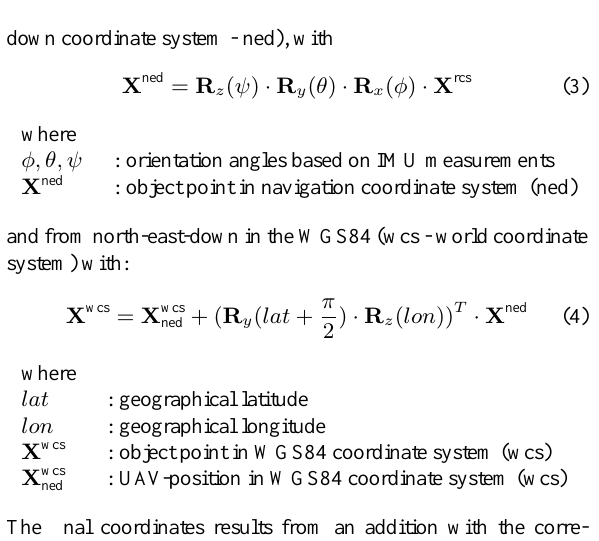
Figure 5: Horizontal profile of pillars from TLS (gray)- and LSRF (blue, red) point cloud with: (a) incorrect yaw angle measurements. (b) corrected yaw angles by approximate correction terms. The pillars are 14.1m in length and 1.4 m in